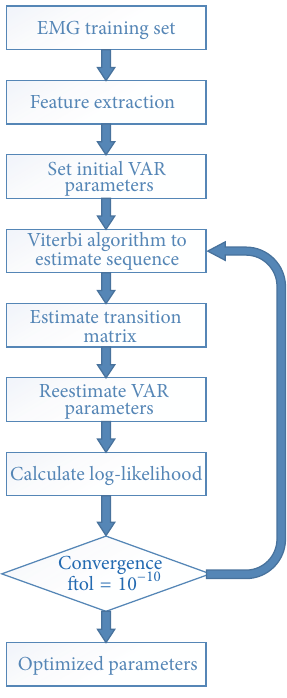
Figure 7: Optimization procedure flowchart. The main load of the optimization procedure is division of movements to segments. With a higher number of segments per movement, the Viterbi algorithm needs a large number of initial conditions for the model to converge to the global minimum instead of converging to a local minimum. This movement dividing method is not deterministic, resulting in slightly different models with every optimization